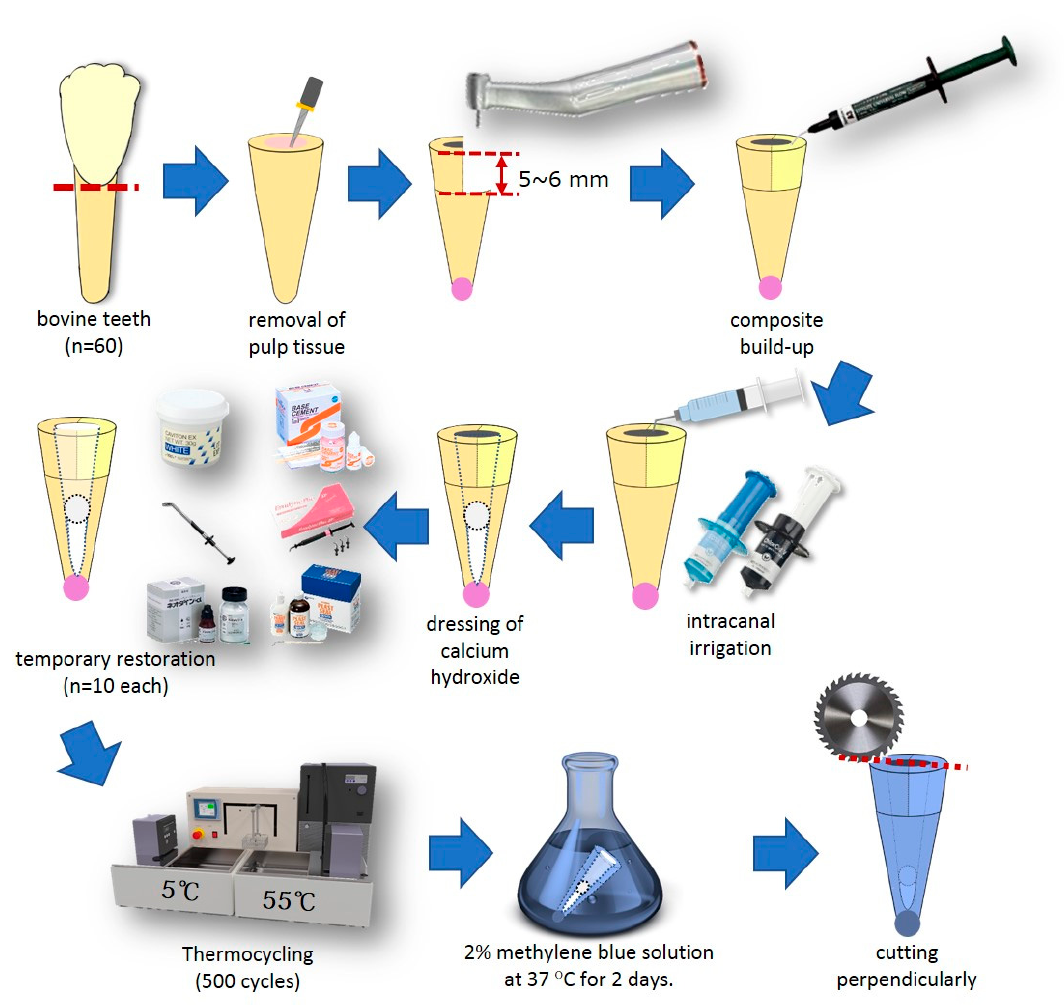
Figure 1. Schematic drawing of the study set-up.